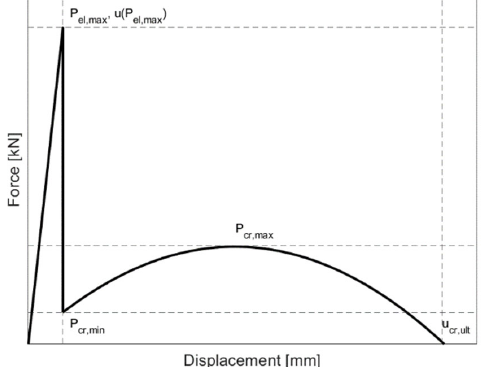
Figure 7. Schematic representation of the global behaviour of the specimens during the experi ‐ ments.